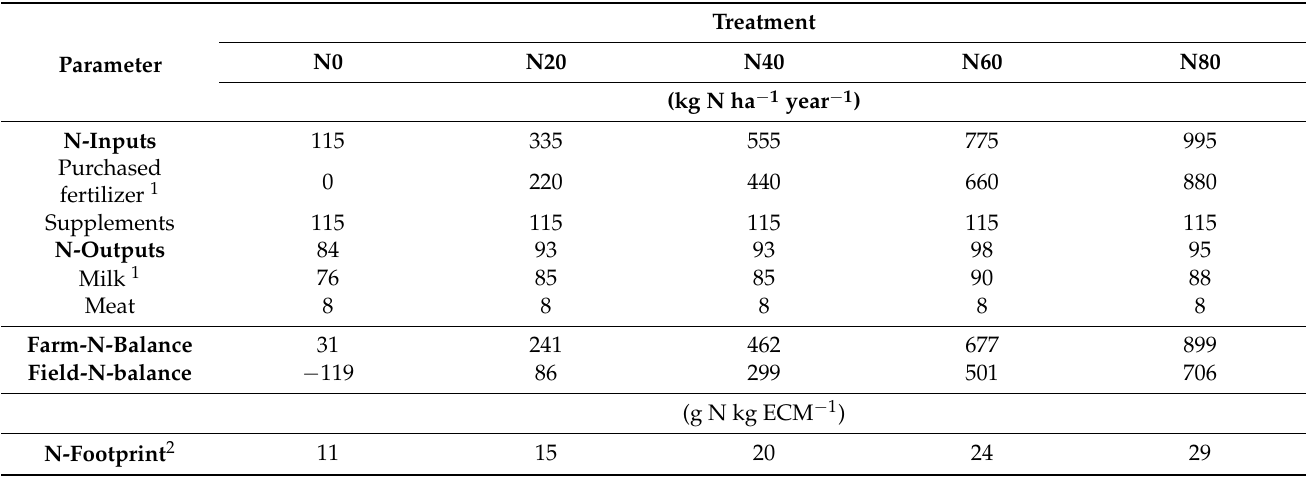
Table A2. Farm-N-balance, field-N-balance (kg N ha − 1 year − 1 ) and N-footprint (g N kg ECM − 1 ) for the different mineral N fertilizer treatments (0N, 20N, 40N, 60N and 80N) used in the current